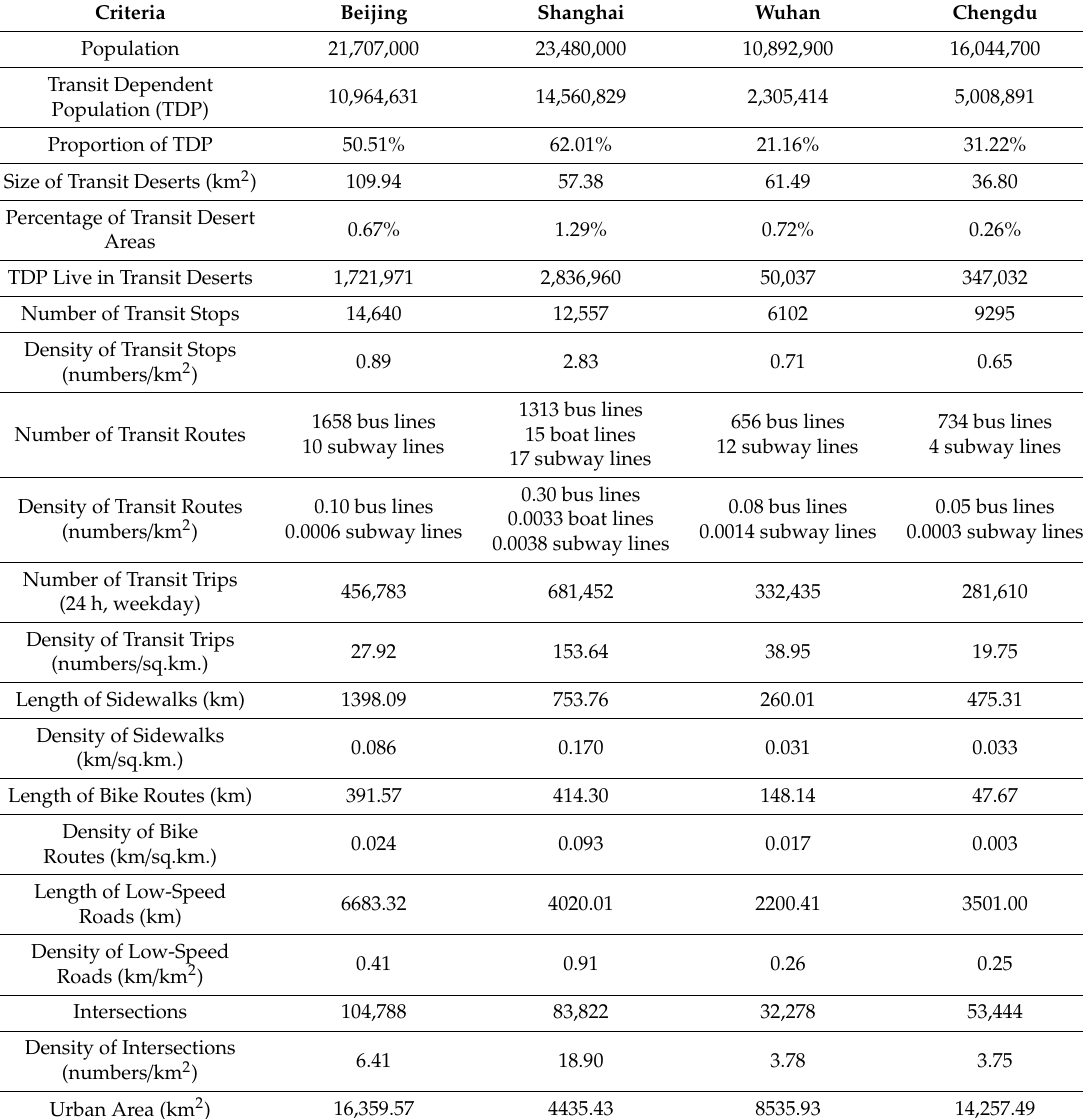
Table 1. Characteristics of transit and built environment in Chinese metropolitan